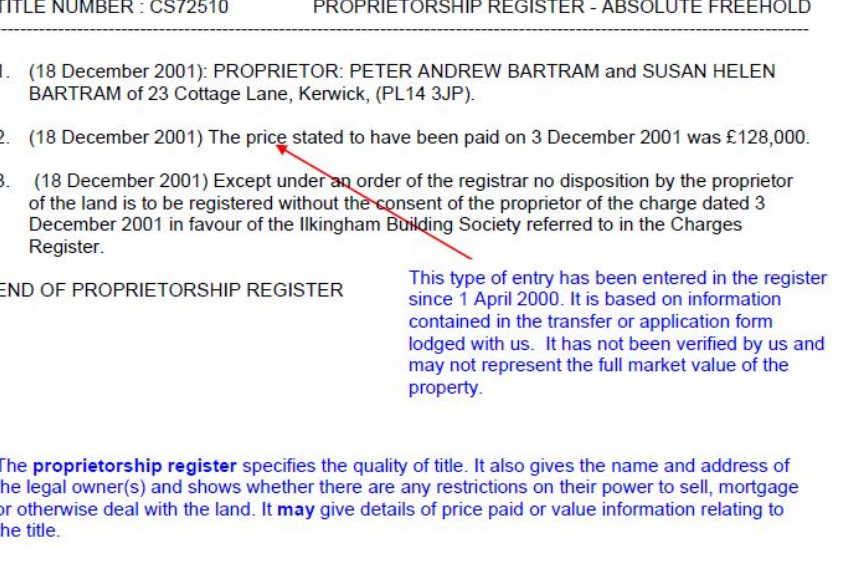
Figure 7. Part of the Title Deed. Source: [31].